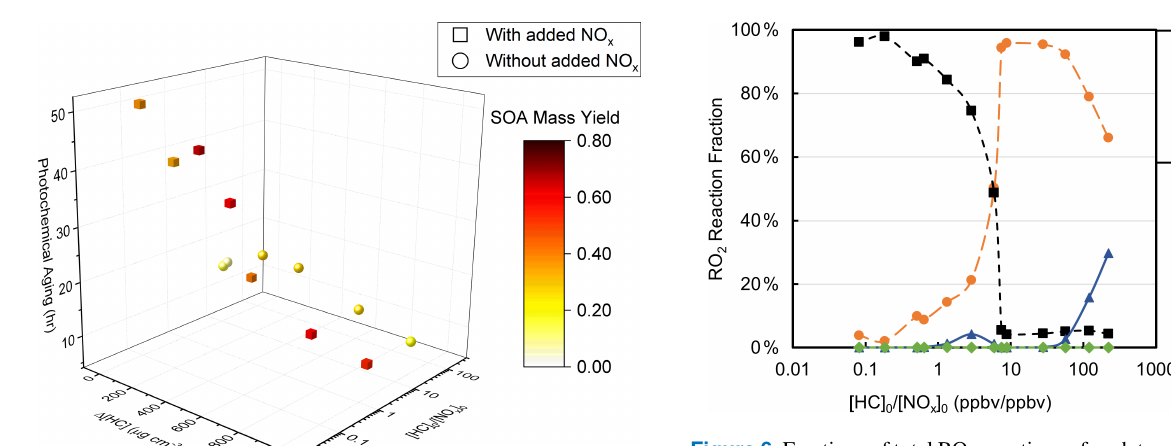
Figure 6. Fractions of total RO 2 reactions of each type as a function of [HC] 0 / [NO x ] 0 based on Table S1.